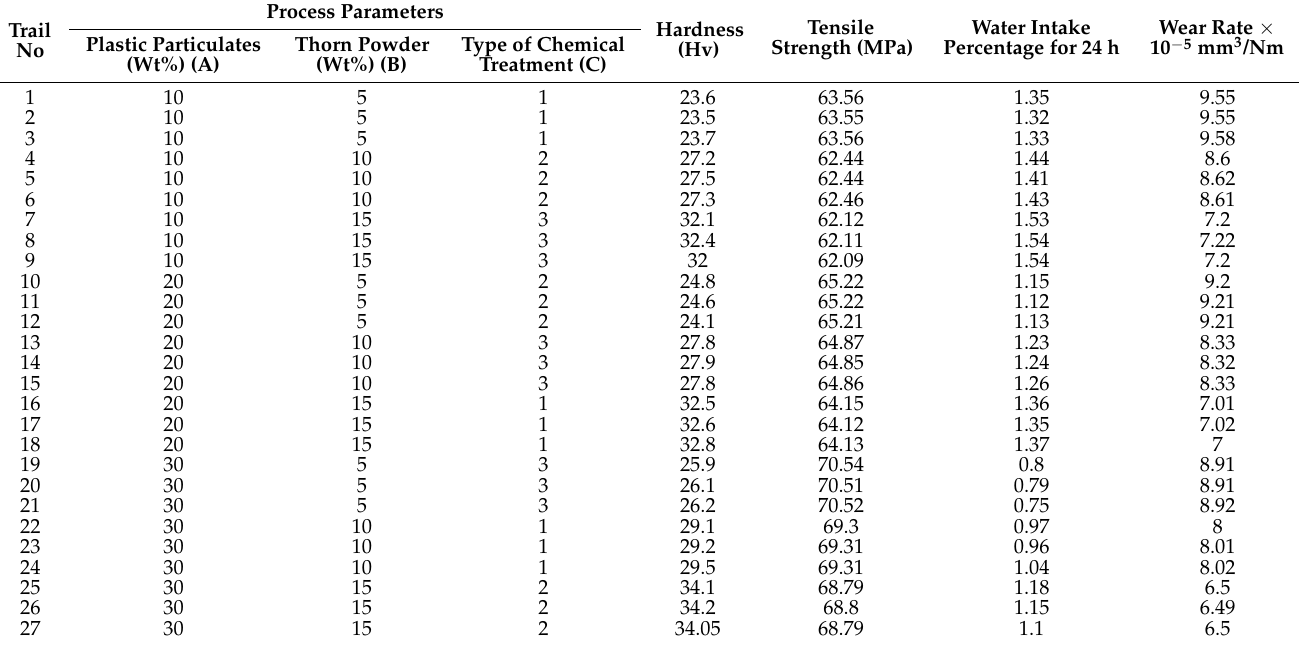
Table 2. Full factorial inputs and